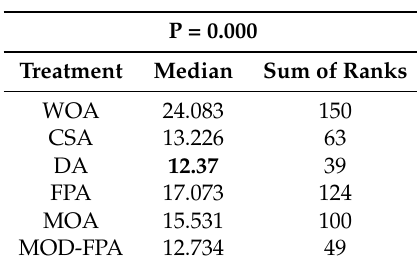
Table 16. Friedman Ranks.